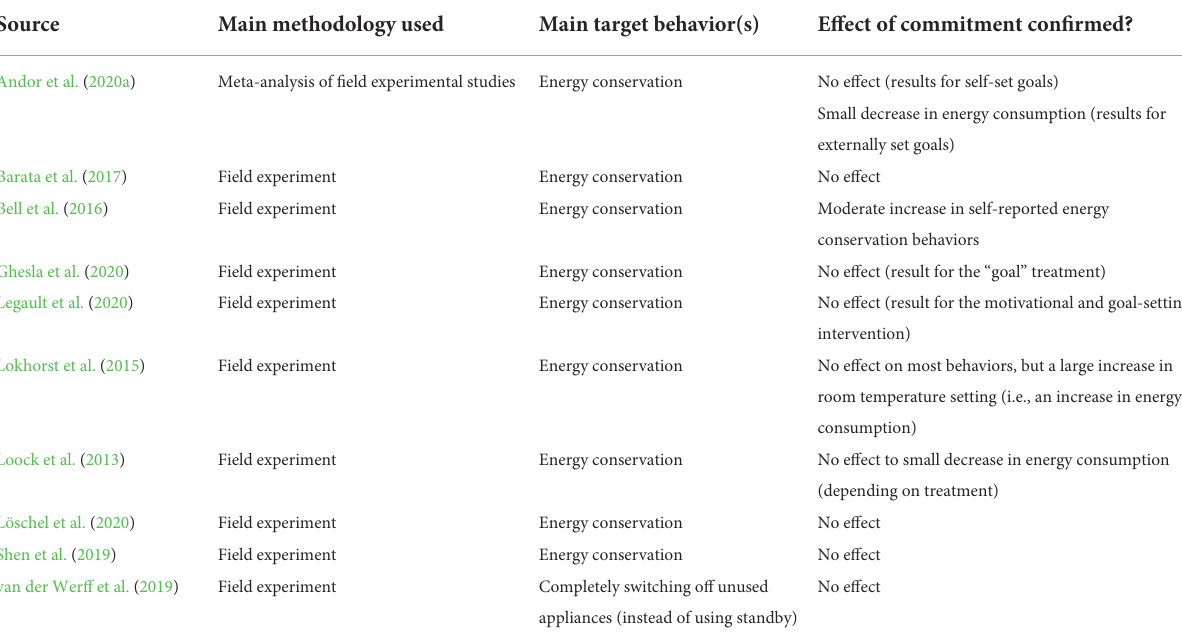
TABLE 2 Overview of former research—commitment and goal